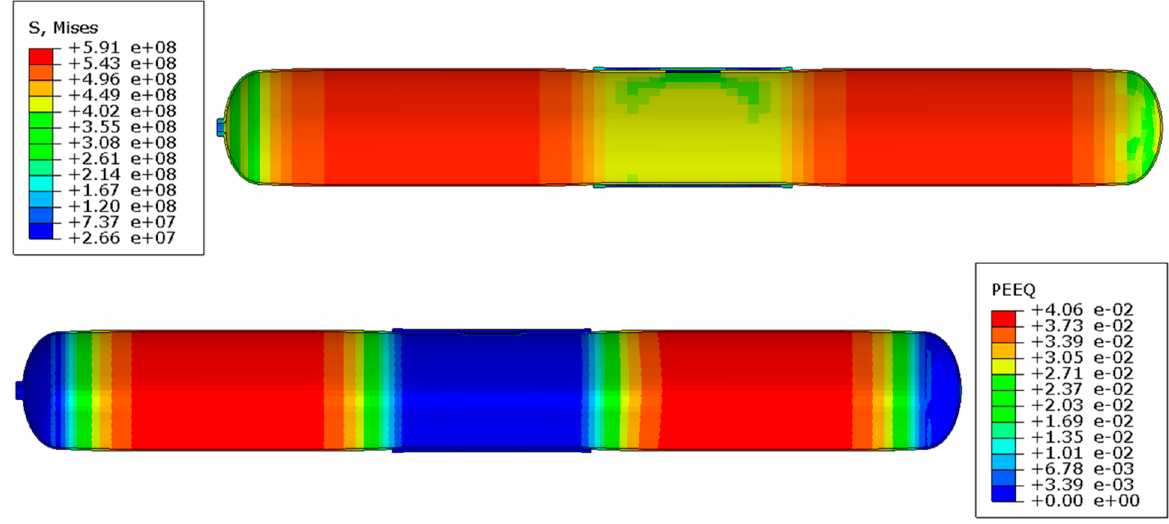
Figure 10. Von Mises stress [Pa] and plastic strain distributions in the FEM global model.